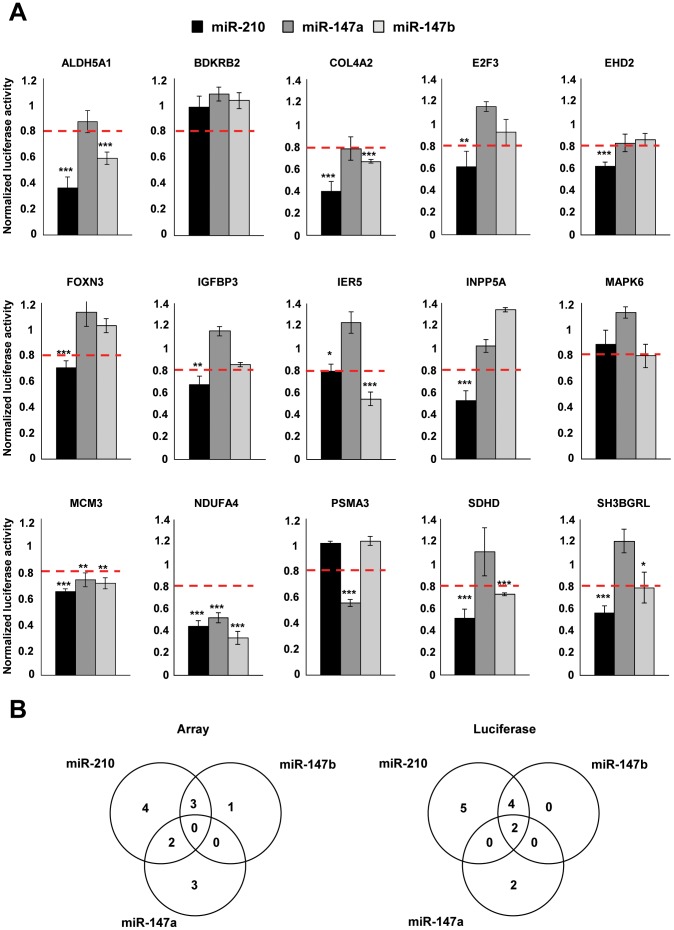
Targets validation using luciferase assays.A) Direct targeting of the 15 candidate transcripts by miR-210, miR-147a and miR-47b was analyzed in vitro. A549 cells were co-transfected with pre-miR-210, pre-miR-147a, pre-miR-147b or pre-miR-Neg and different pSI-Check-2™ constructs containing the 3′UTR of interest described in Table S5. Cells were harvested two days after transfection and luciferase activities were analyzed. B) Venn diagram summarizing the predicted (using the microarray approach) and validated (after luciferase assay) common targets of miR-210 and miR-147 family members. (*p<0.05, **p<0.005, ***p<0.0005).